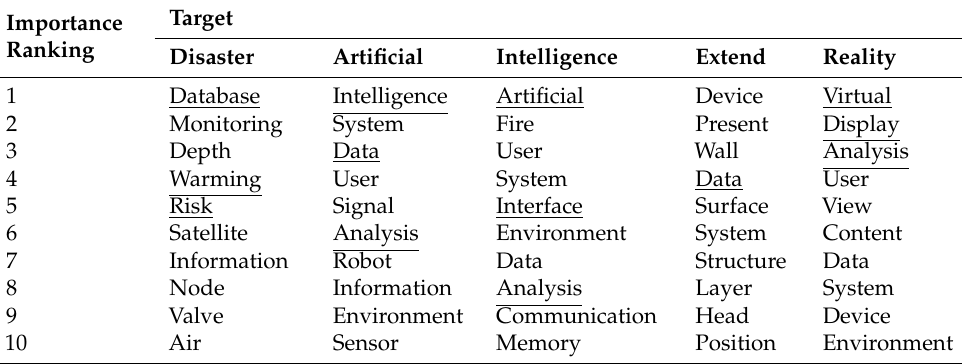
Table 3. Variable importance ranking of explanatory keyword for